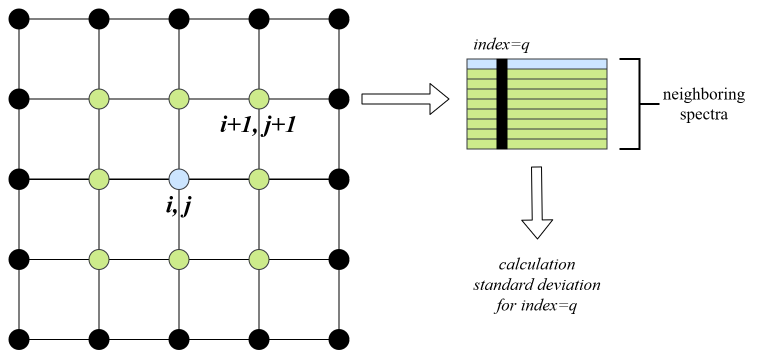
Figure 6. The scheme for computing the standard deviation estimate for the noise generation (the case of 2D parameter space is considered for lucidity). On the left, the blue dot represents the spectrum S i , j in 2D parameter space, green dots show spectra in neighbor points in parameters space S i + k , j + w , where k , w ∈ [ − 1,0,1 ] . On the right, the blue line corresponds to the S i , j spectrum, whereas green lines depict the S i + k , j + w spectra. The black vertical line shows spectral density values for index q (indicating the frequency) that are used for standard deviation